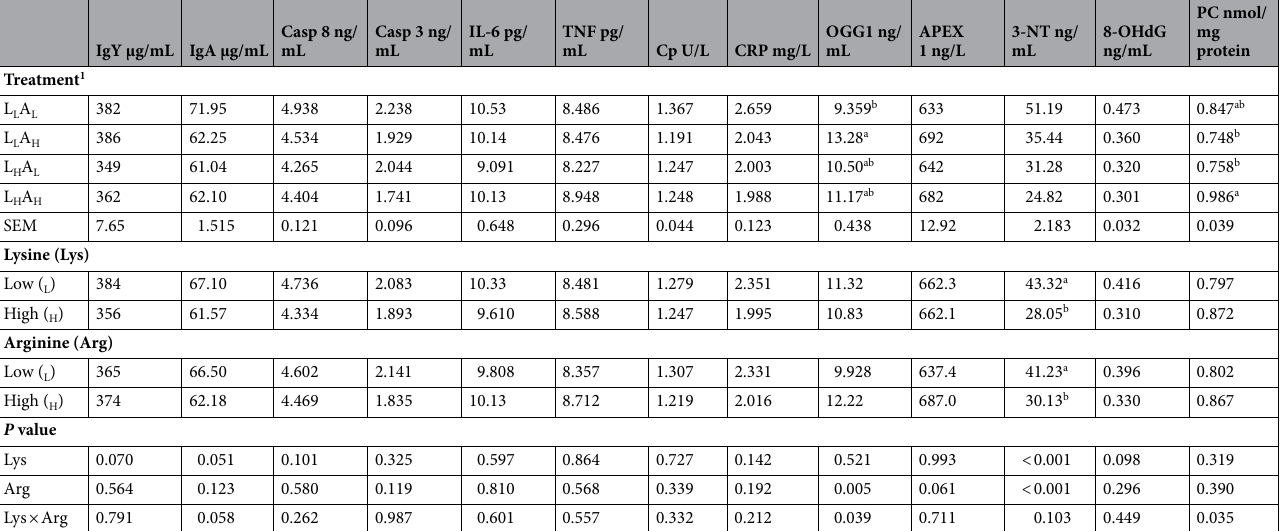
Table 4. Blood immunological and redox parameters of turkeys at 16 weeks of age. 1 L L A L diet with low Lys and low Arg levels;